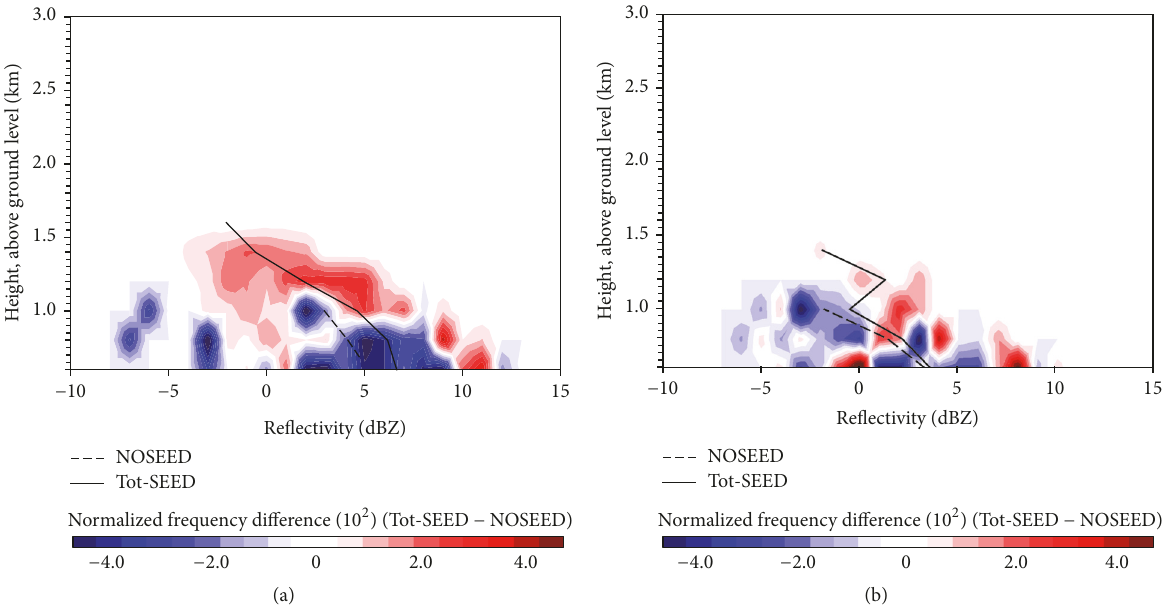
Figure 8: Normalized frequency difference from the MRR between NOSEED (dashed) and Tot-SEED (solid) at YP for (a) EXP1 and (b)